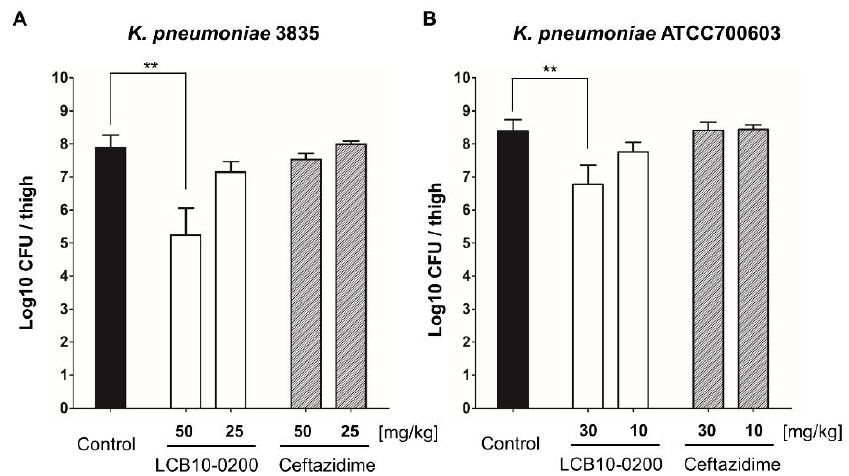
Figure 2. In vivo activity of LCB10-0200 in the thigh infection mouse model. Therapeutic efficacies of LCB10-0200 and ceftazidime in the thigh infection mouse model against two ceftazidime—resistant K. pneumoniae strains (( A ) K. pneumoniae 3835; ( B ) K. pneumoniae ATCC700603). Each bar represents mean ± SD (standard deviation of the mean; n = 3; ** p < 0.01).